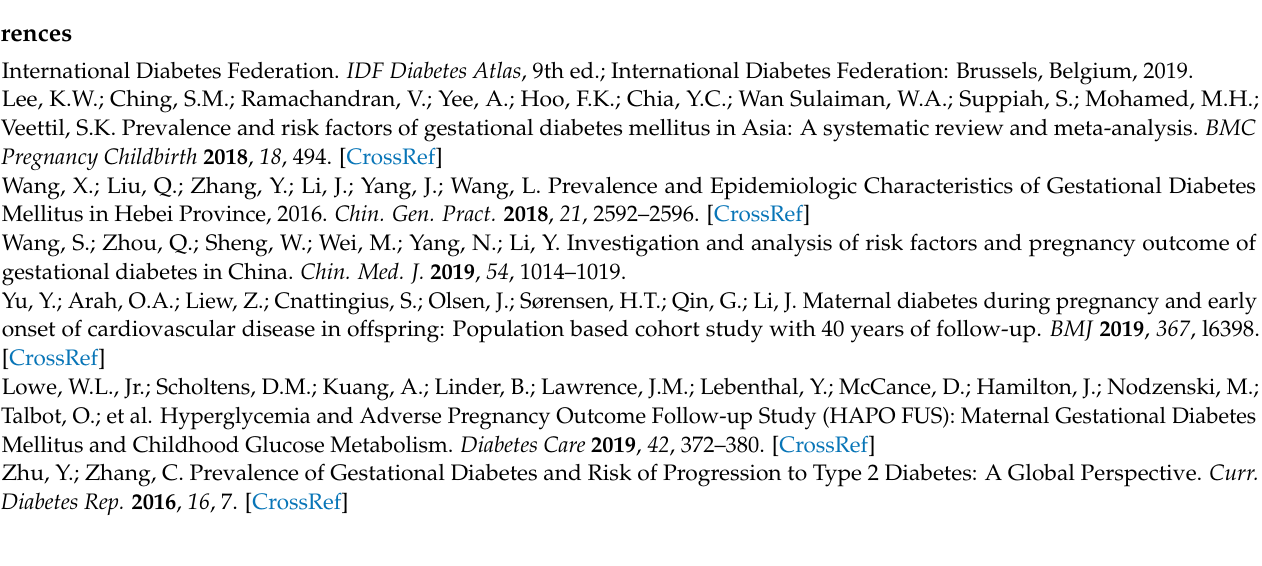
between QC samples of AF under the negative mode, Figure S3a: PCA score plots for serum samples from CON and GDM, Figure S3b: PCA score plots for AF samples from CON and GDM, Figure S4a: OPLS-DA score plots of serum samples for CON vs. GDM, Figure S4(b): OPLS-DA score plots of AF samples for CON vs. GDM, Figure S4c: Permutation plot of OPLS-DA model of serum samples, Figure S4d: Permutation plot of OPLS-DA model of AF samples, Figure S4e: Volcano plot of serum samples for CON vs. GDM, Figure S4f: Volcano plot of AF samples for CON vs. GDM, Figure S5a: Heat map of hierarchical clustering analysis for differential metabolites in serum samples from CON and GDM, Figure S5b: Heat map of hierarchical clustering analysis for differential metabolites in AF samples from CON and GDM, Table S1: The identified differential metabolites in serum samples exposed to GDM, Table S2: The identified differential metabolites in AF samples exposed to